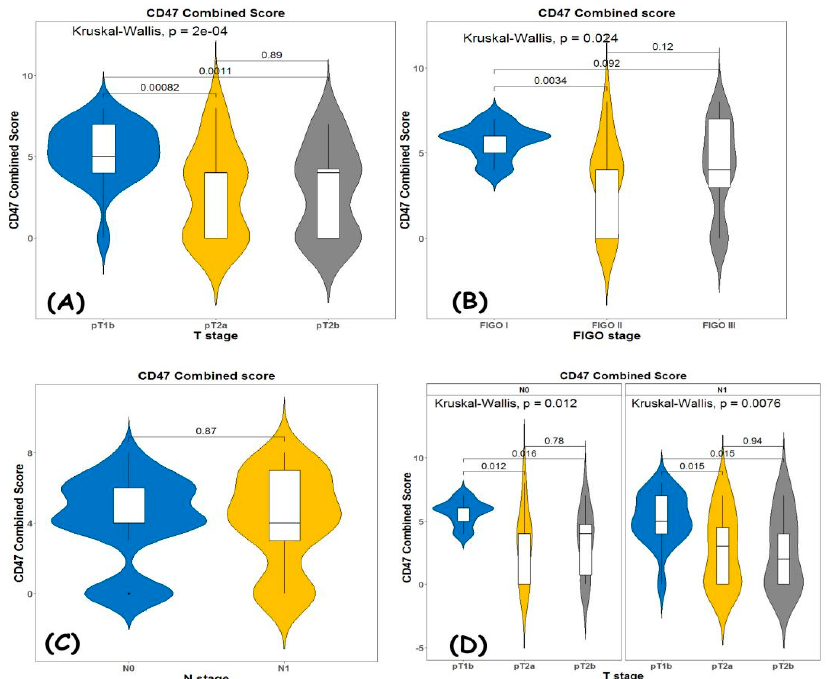
Figure 5. Kruskal–Wallis test for the association between ( A ) TNM T stage and combined score; ( B ) FIGO stage and combined score; ( C ) N status and combined score; and ( D ) T stage and combined score in node negative and node positive patients.